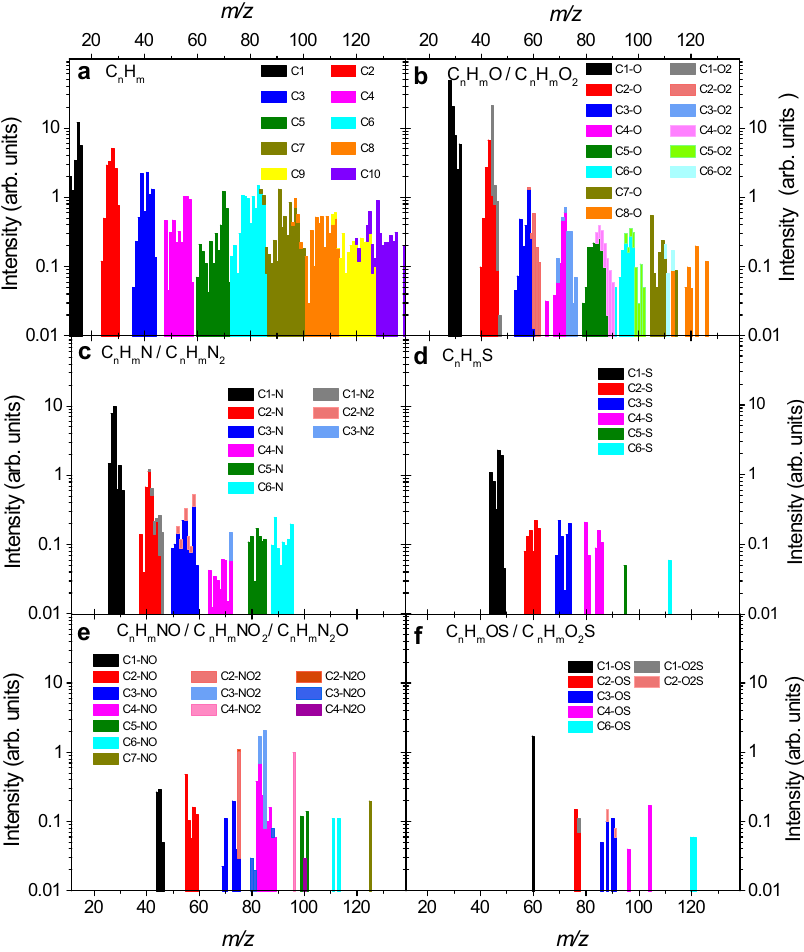
Fig. 1 C-bearing species identi fi ed on 3 August 2015 by the Double Focusing Mass Spectrometer (DFMS). Signal intensities of parent and fragment species in arbitrary units (arb. units) are plotted as a function of the corresponding integer m/z value. The statistical 1 σ uncertainty of the signals is estimated to be 15 – 35%, but error bars are omitted for visual clarity. The different panels show the different subgroups of species: a pure hydrocarbon species, b O-bearing species, c N-bearing species, d S-bearing species, e NO-bearing species, and f OS-bearing species. Very rare and low-intensity NS- bearing species are not shown here. m and n indicate variable numbers of C and H atoms,